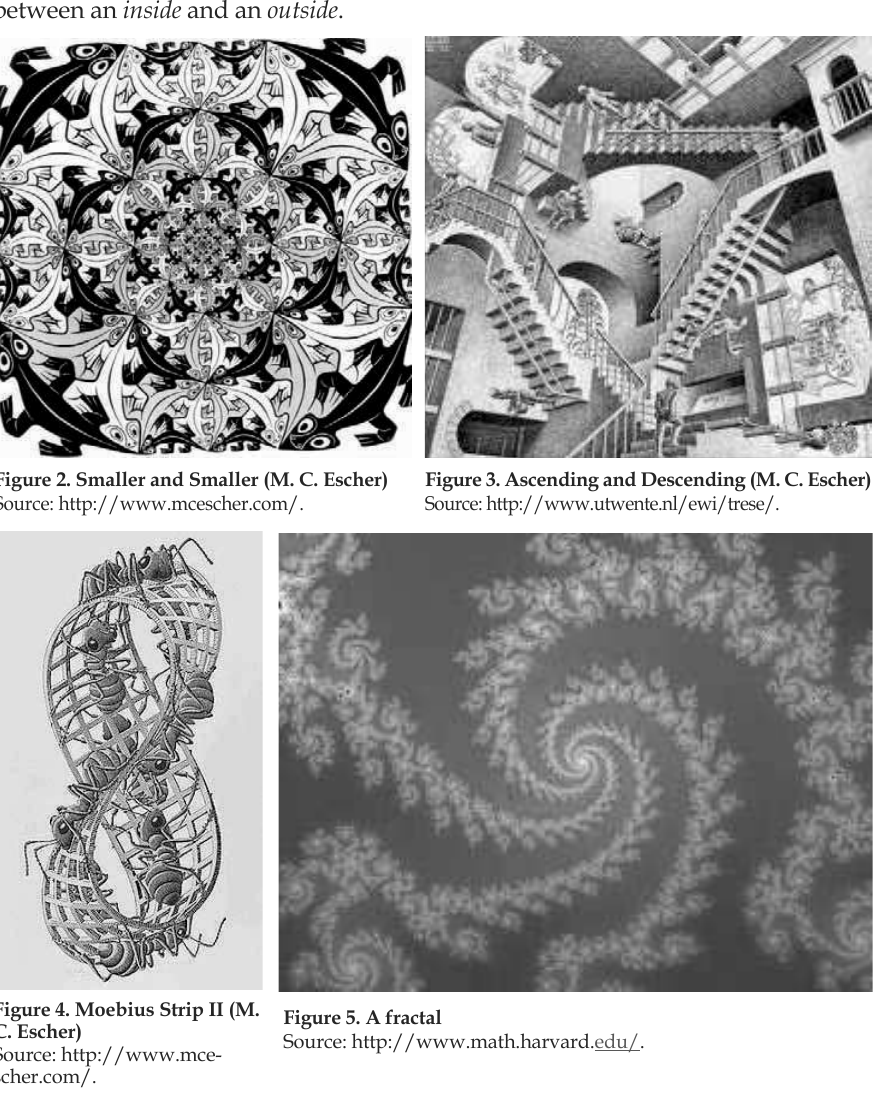
Figure 5. A fractal Source: